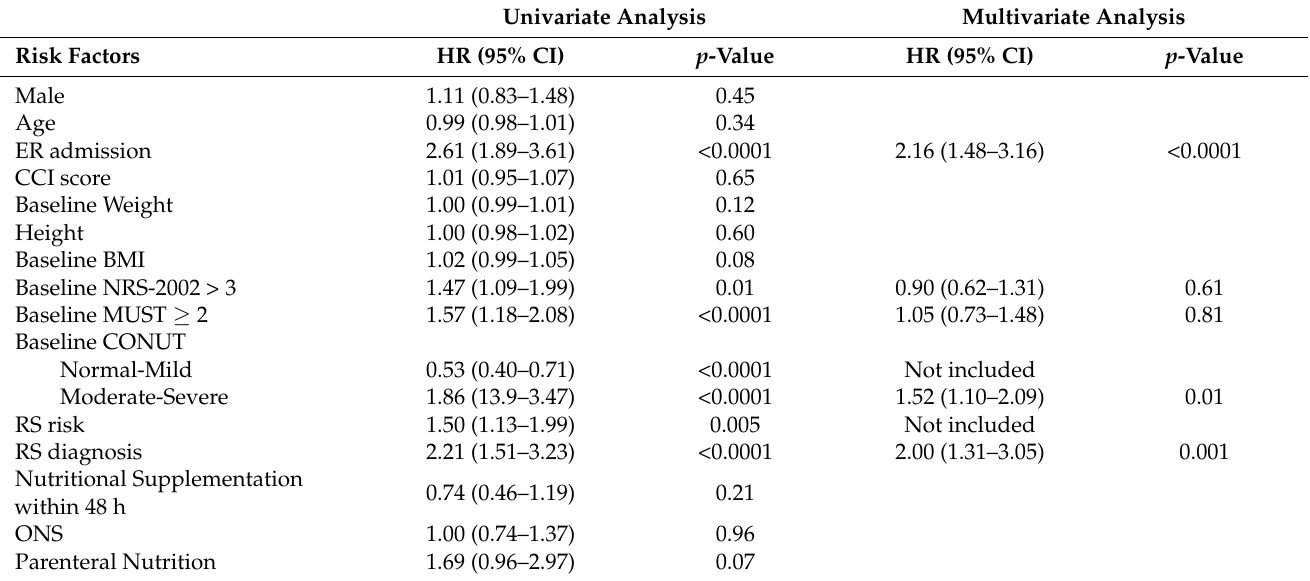
Table 4. Univariate and multivariate analyses of risk factors associated with LOS (n = 203). Univariate Analysis Multivariate Analysis